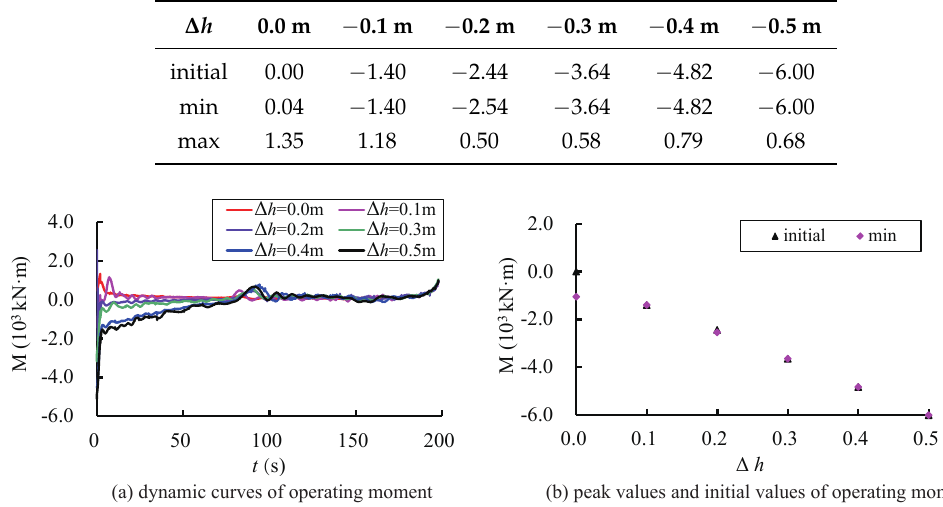
Table 7. The hydrodynamic resistance moment at various submergence depths (unit: 10 3 kN · m).